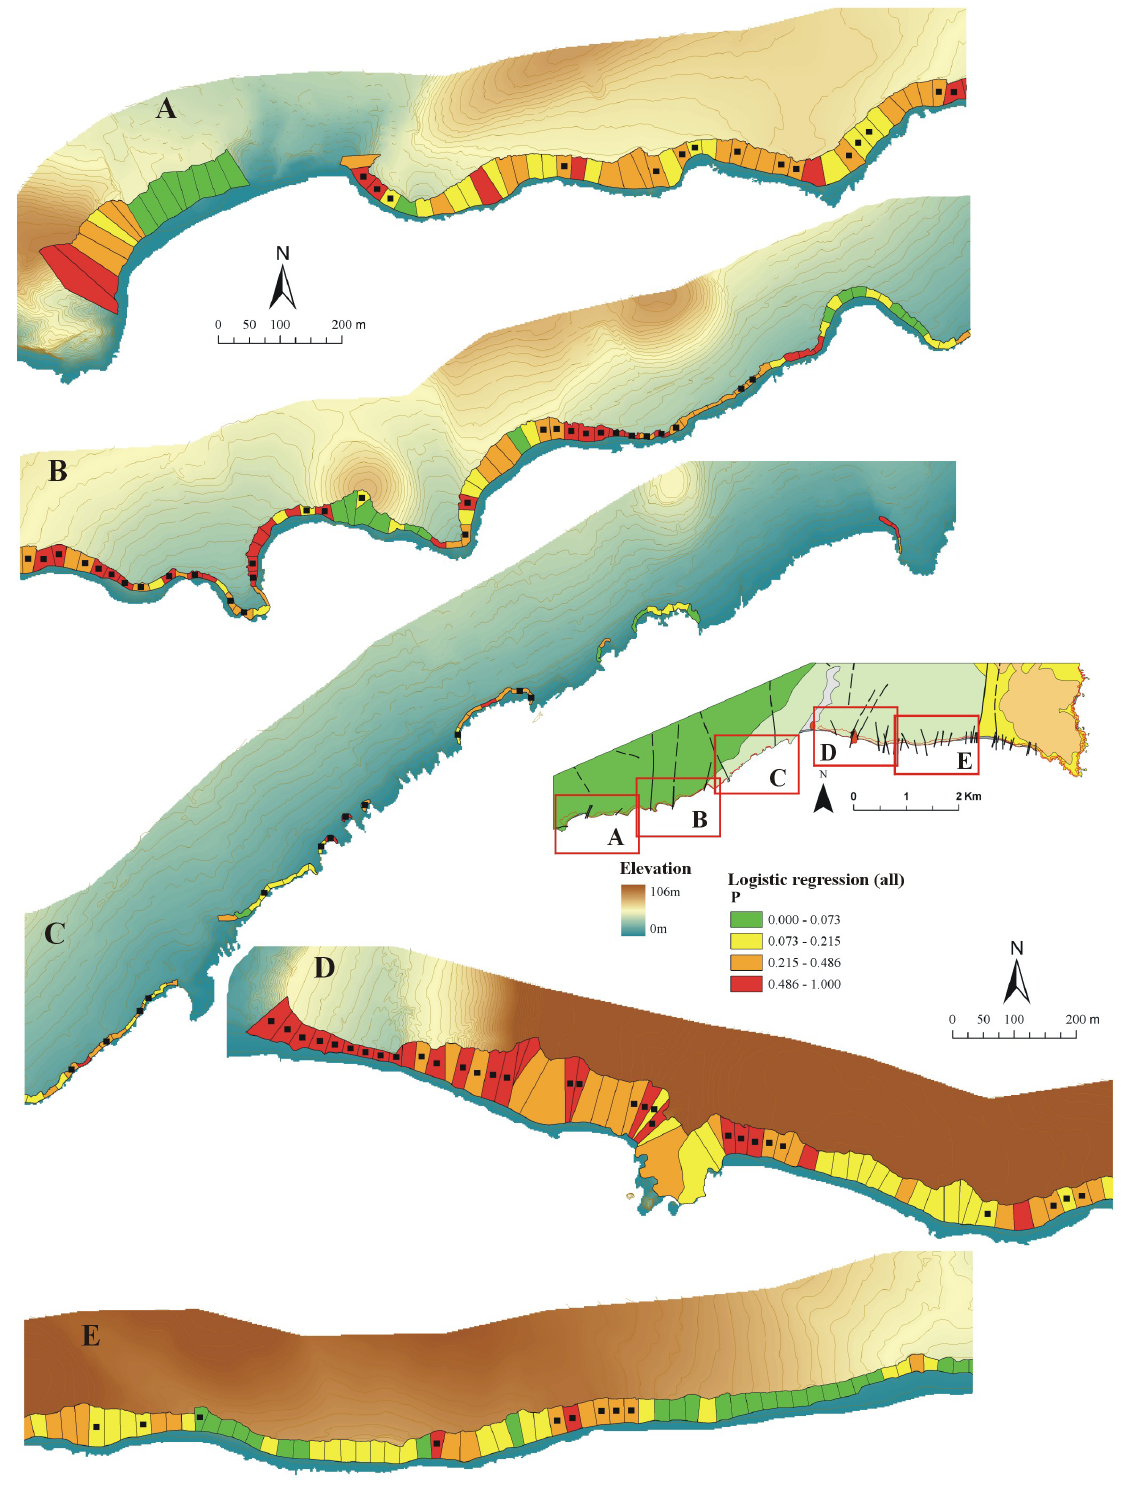
Fig. 8. Susceptibility mapping (1 / 2) based on the logistic regression model with all factors, with indication (dot) of the terrain units with cliff failures, for the cliff sections A, B, C, D and E, with general legend and localization map. Classification of logistic regression probability values in quantile-based classes. Contour line interval is